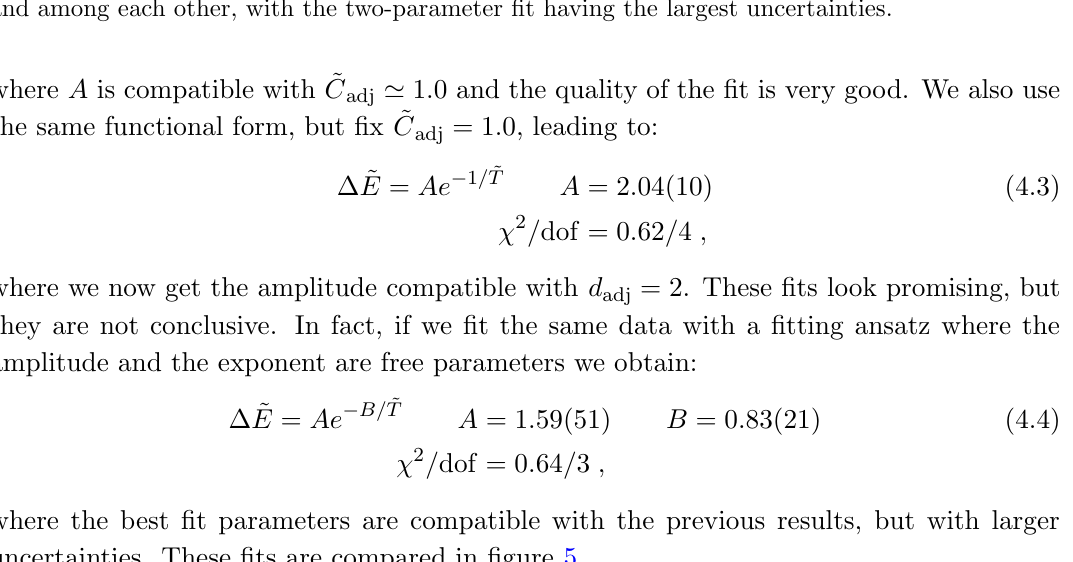
Figure 5. Di(cid:11)erent exponential (cid:12)ts are shown together with the data. Only (cid:12)ve rightmost data points are included in the (cid:12)ts, corresponding to ~ T 0 : 8. The (cid:12)ts are all compatible with the data (cid:20) and among each other, with the two-parameter (cid:12)t having the largest